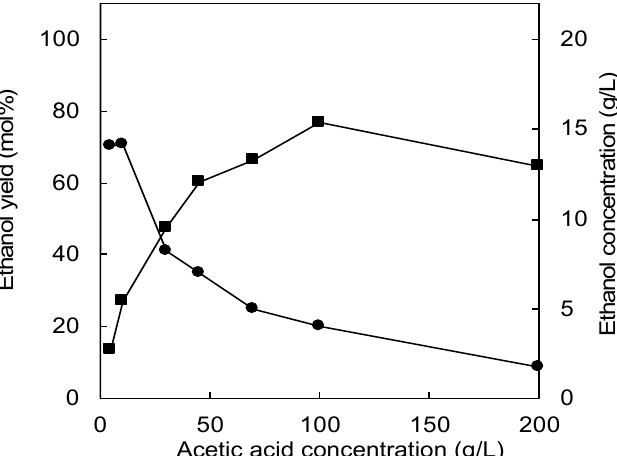
Figure 2. Effect of acetic acid concentration on ethanol yield in hydrogenation of aqueous acetic acid to ethanol at 250 °C (column size, 3.9-mm inner diameter, 100-mm length; pump flow rate, 0.3 mL/min; H 2 flow rate, 60 mL/min; pressure, 10 MPa).